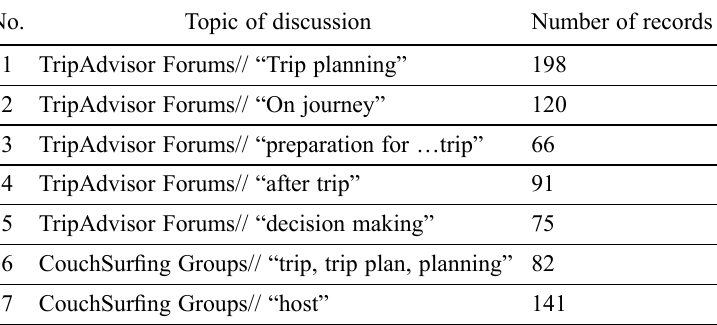
Table 2. Selected online forums and discussions for netnographic research